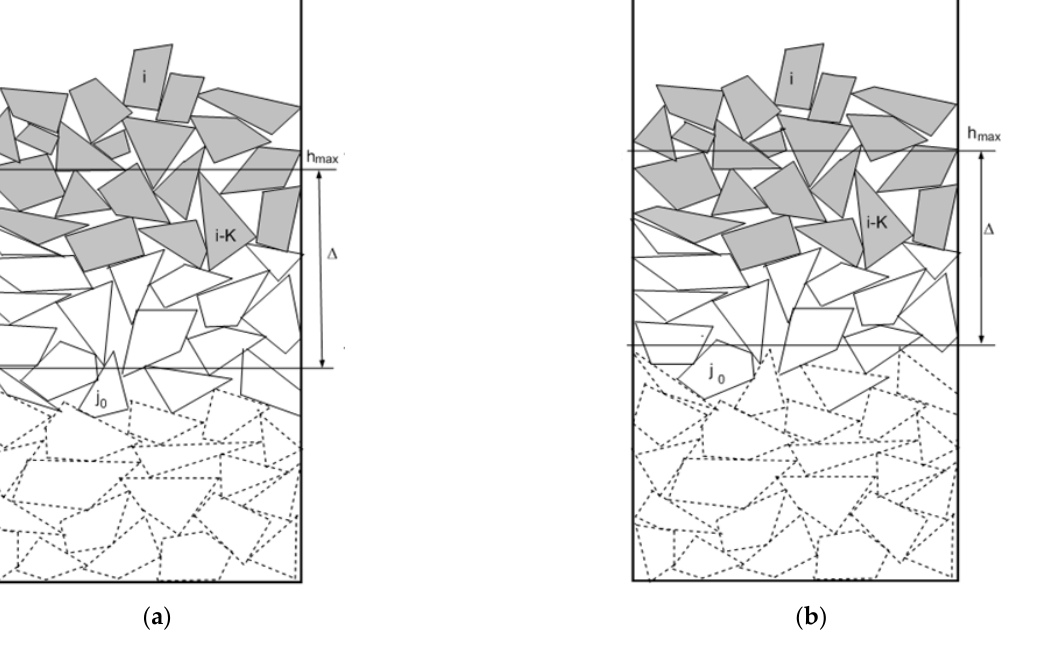
Figure 2. Illustrations to step 7: ( a ) i z  m a x ; i h R + −  ( b ) recalculation of the values ℎ 𝑚𝑎𝑥 and Δ of Figure 1. Illustrations to step 7: ( a ) z i > h max + R i − ∆ ; ( b ) recalculation of the values h max and ∆ of the active the active layer.